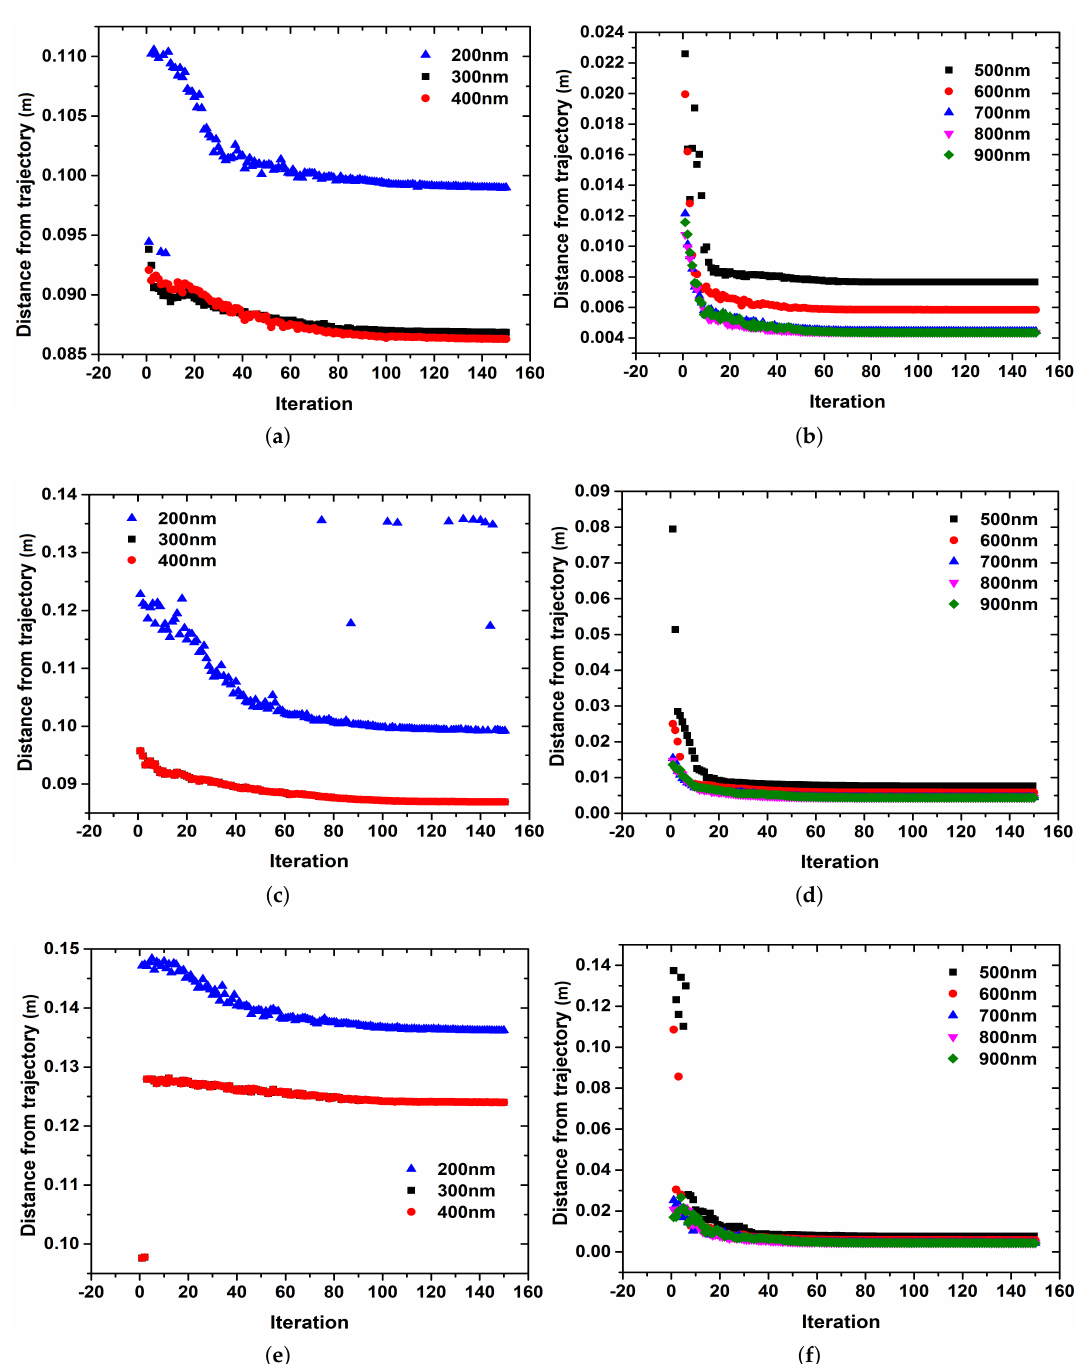
Figure 8. ( a , b ) Best, ( c , d ) Average and ( e , f ) Worst distance of particles in each iteration from the desired